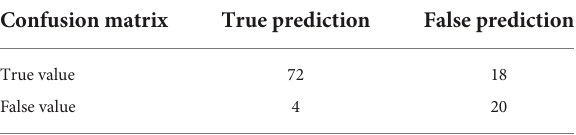
TABLE 7 Confusion matrix for the External II